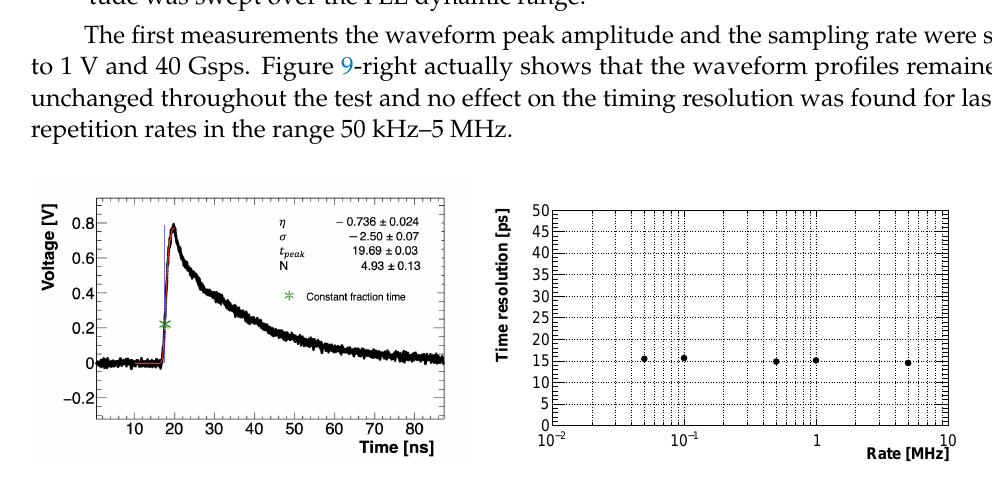
Figure 9. ( Left ): SiPM waveform in response to a laser pulse, sampled at 40 GS/s. Log-normal fit on the rising edge is overlaid. ( Right ): Effect of laser repetition rate on the time resolution.